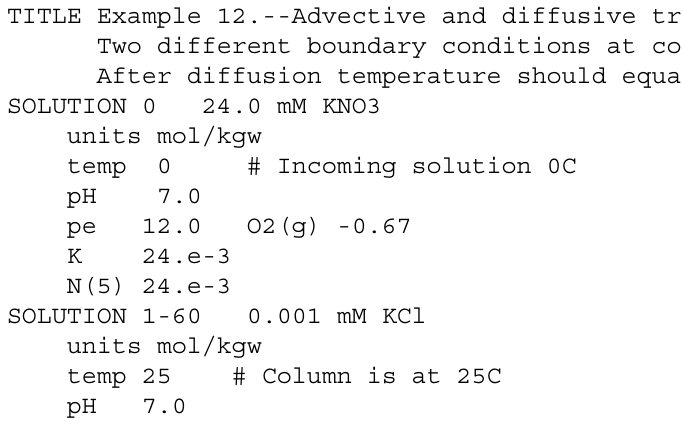
Table 31. Input file for example 12. TITLE Example 12.--Advective and diffusive transport of heat and solutes. Two different boundary conditions at column